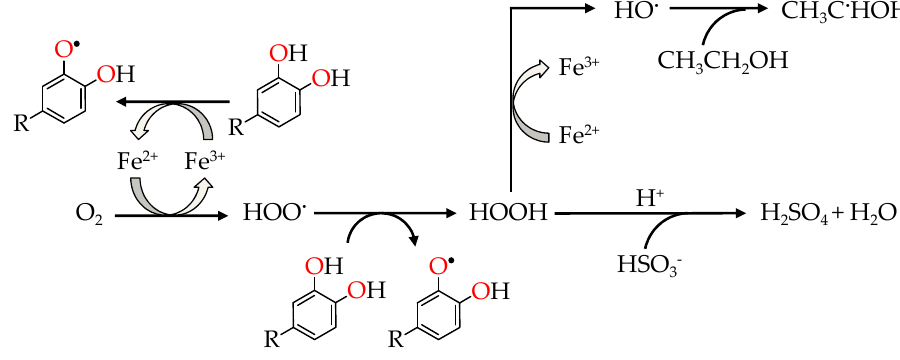
Figure 2. Fe-catalysed wine oxidation scheme [25].